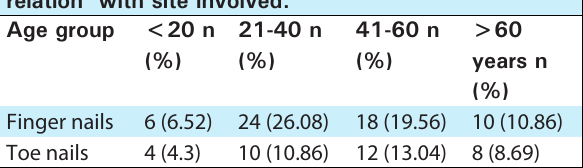
Table 1. Age wise distribution of onychomycosis in